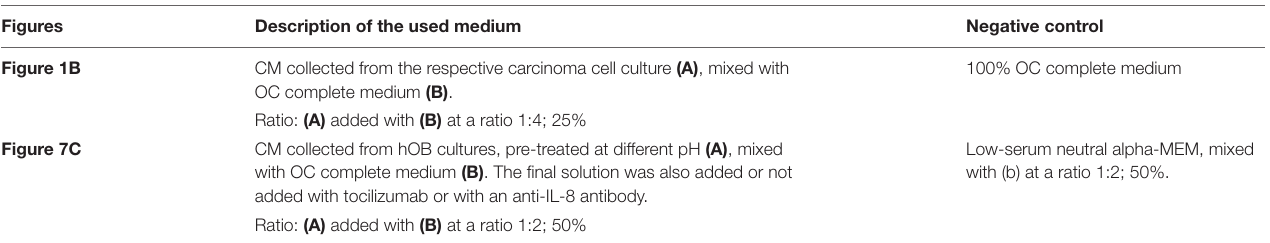
TABLE 1A | Description of the conditioned medium used in the different experiments. Figures Conditions/treatments Negative control Figure 1A CM collected from the respective carcinoma cell culture (A) , mixed with OC complete medium (B) . Ratio: (A) added with (B) at a ratio 1:4; 25% Figure 5A CM collected from hOB cultures, pre-treated at different pH (A) , mixed with OC complete medium (B) . Ratio: (A) added with (B) at a ratio 1:2; 50% Figure 7B CM collected from hOB cultures, pre-treated at different pH (A) , mixed with OC complete medium (B) . The final solution was also added or not with tocilizumab or with an anti-IL-8 antibody. Ratio: (A) added with (B) at a ratio 1:2; 50% TABLE 1B | Description of the conditioned medium used in the different experiments. Figures Description of the used medium Negative control Figure 1B CM collected from the respective carcinoma cell culture (A) , mixed with OC complete medium (B) . Ratio: (A) added with (B) at a ratio 1:4; 25% Figure 7C CM collected from hOB cultures, pre-treated at different pH (A) , mixed with OC complete medium (B) . The final solution was also added or not added with tocilizumab or with an anti-IL-8 antibody. Ratio: (A) added with (B) at a ratio 1:2;